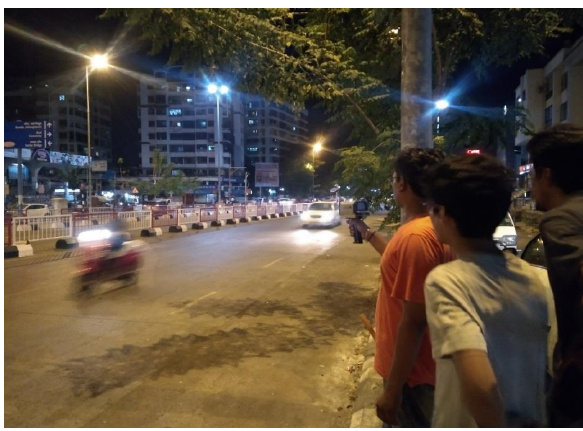
Figure 3: View of location 2-B 1